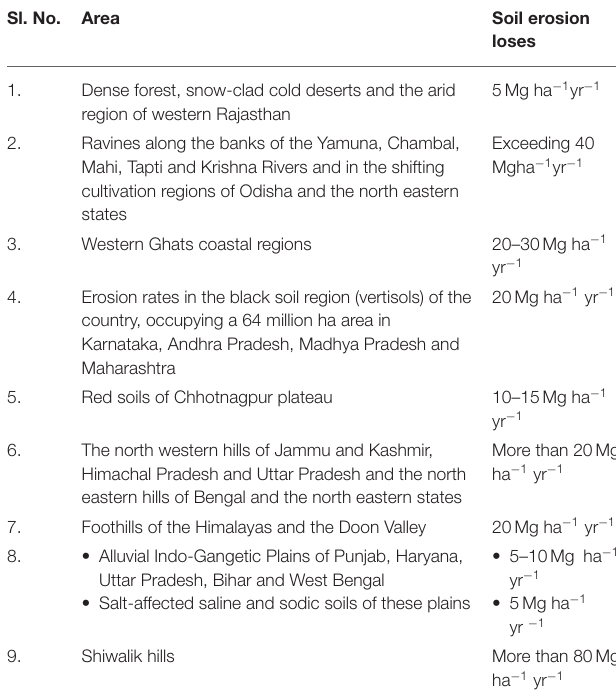
TABLE 5 | Soil erosion losses in different parts of India. Sl. No.